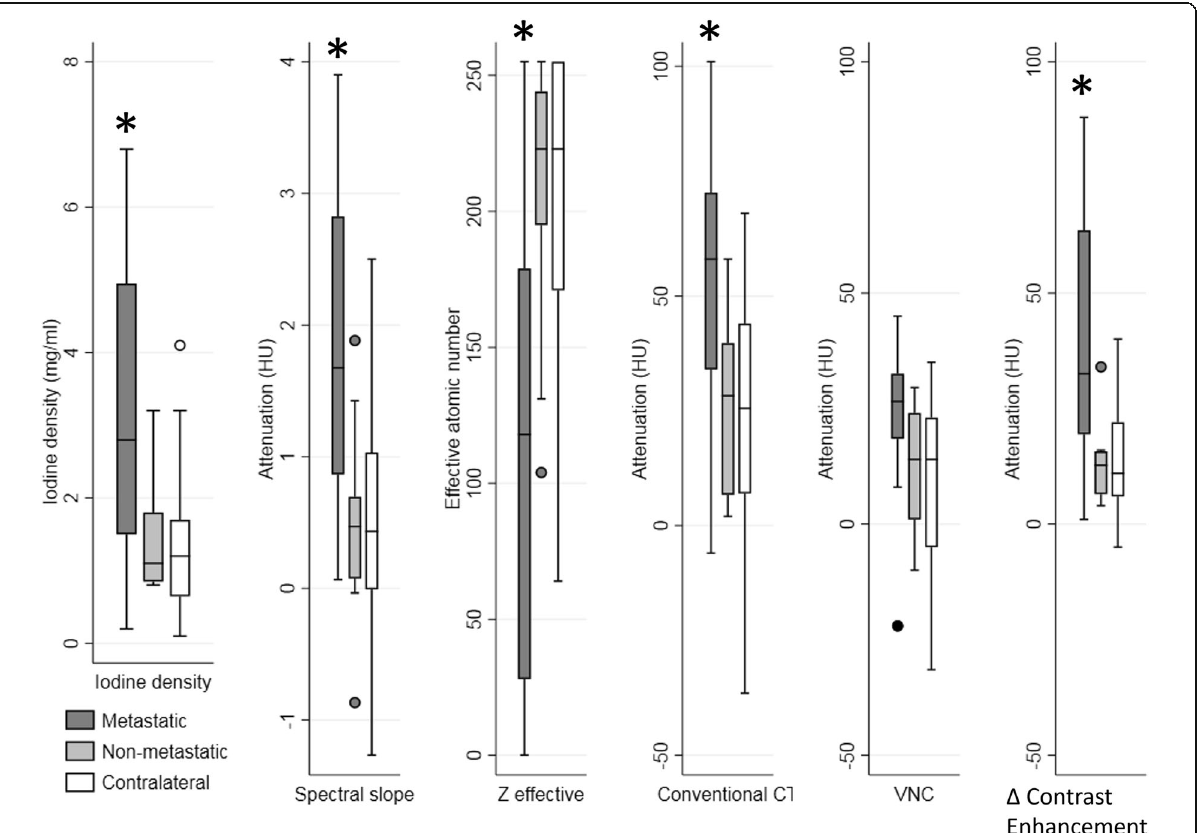
Fig. 3 Box chart of quantitative dual-layer spectral CT parameters from metastatic, non-metastatic and contralateral axillary lymph nodes. Metastatic lymph nodes had significantly different iodine density, spectral slope, Z effective, Δ contrast enhancement, and conventional CT HU compared to both non-metastatic ipsilateral and contralateral lymph nodes as denoted by the asterisk. CT Computed tomography, VNC Virtual